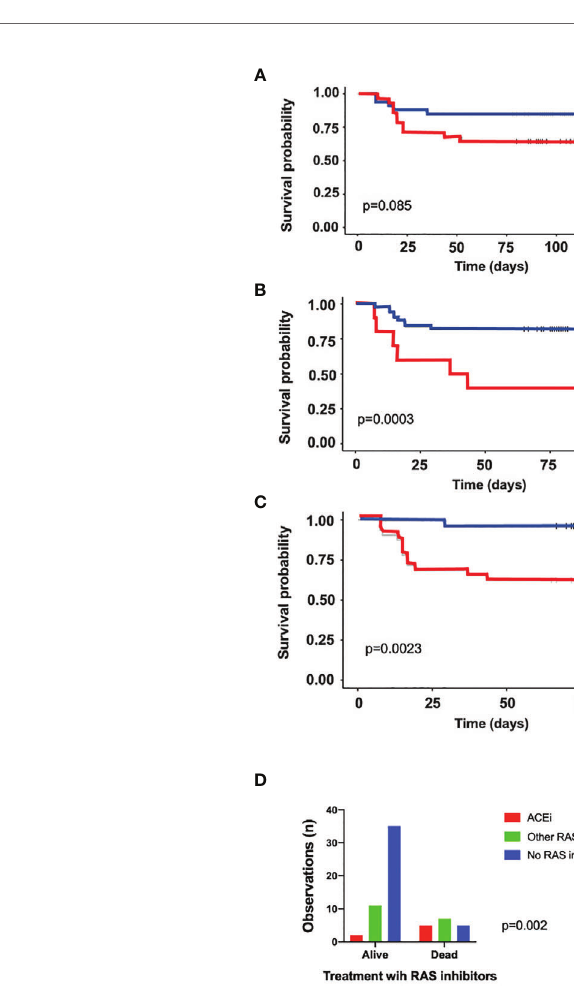
FIGURE 4 | Association of intravascular innate immune system activation in COVID-19 ARDS with death. Kaplan-Meier plots of C3a/C3 (A) , Prekallikrein (B) and HK (C) further stressed, that both the complement and the kallikrein/kinin systems are more activated in the patients who later died during their stay in the ICU. In panel (D) it is shown that the proportion of patients who died during the ICU stay was much higher in the group treated with ACE-1 inhibitors than among the patients on other types of renin-angiotensin system (RAS) inhibitors and those that did not take any RAS inhibitors at all. The presented data are from 66 consecutive patients with COVID-19 and for statistical evaluation non-parametric Mann Whitney U, Chi 2 and Kaplan-Meier tests were used. HK, high molecular weight kininogen; ACEi, ACE-1 inhibitors; RAS, renin-angiotensin